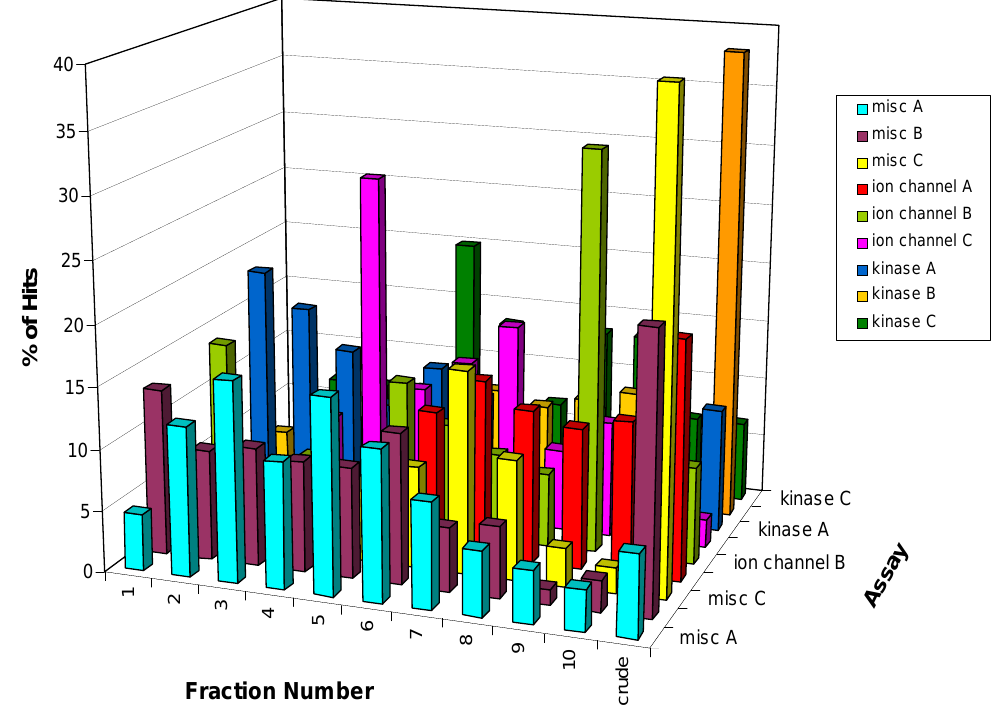
Figure 6. Distribution of the 2750 HTS hits from 9 screens showing the assay- dependency